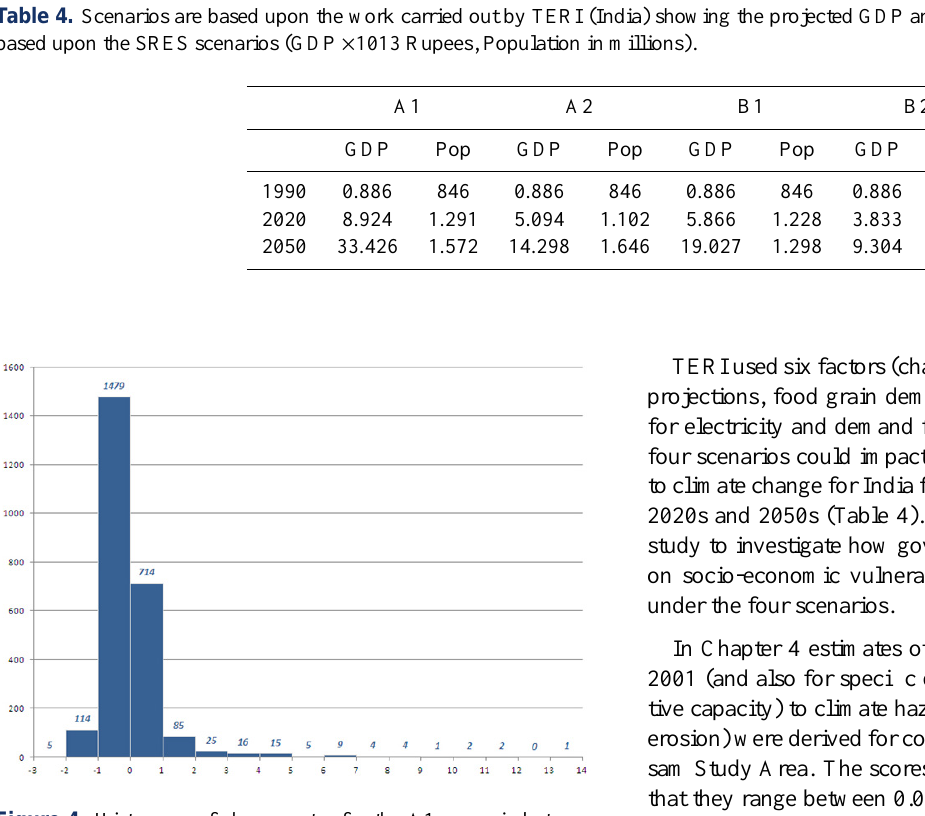
Figure 4. Histogram of change rates for the A1 scenario between 2000 and